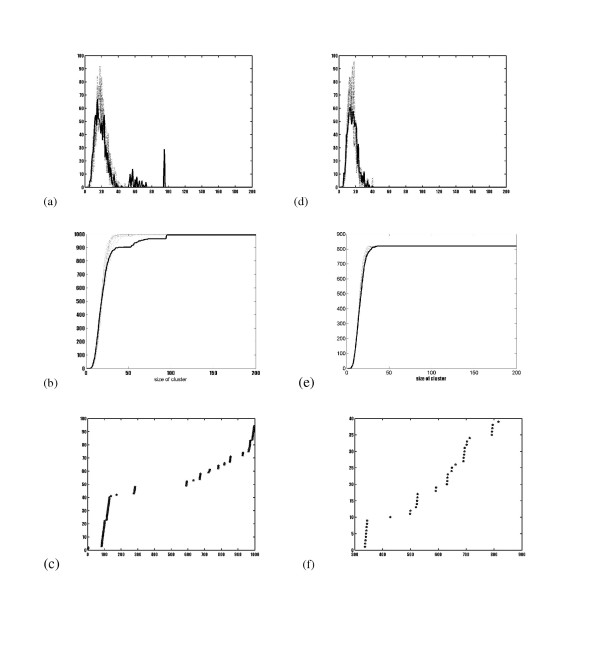
Non-coding presumed non-regulatory sequence before and after repeat-masking. For a non-coding, non-regulatory sequence, randomly picked from chromosome 3L. Panels (a,b,c) show results before repeat-masking; panels (d,e,f) show results after repeat-masking. Panels (a,d) show histograms of similar words (solid: original data; dotted: after random shuffling) as in Figure 1; panels (b,e) show the same data in cumulative form as in Figure 3; panels (c,f) show start locations of similar words as in Figure 7.